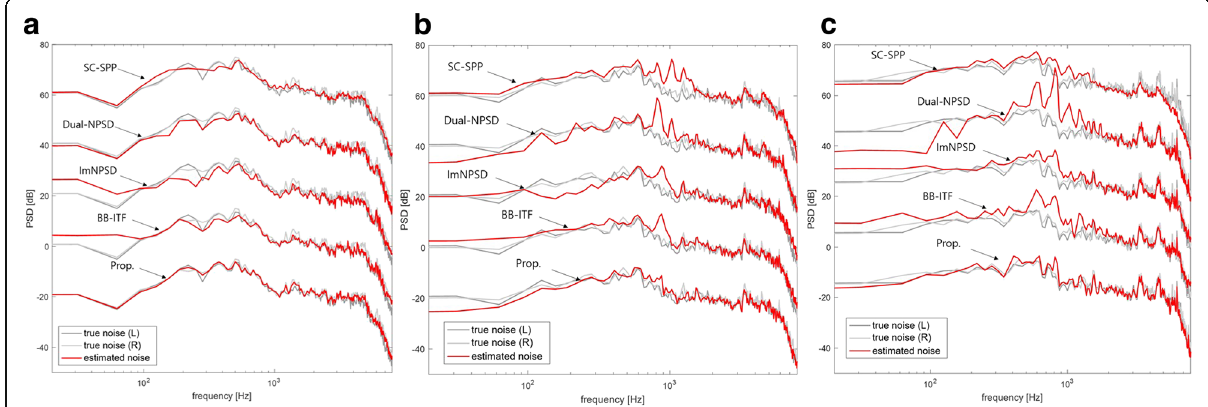
Fig. 8 Estimated noise PSD spectra: a speech absence region, b speech presence region with a speech source at 0° azimuth, and c speech presence region with a speech source at − 90° azimuth